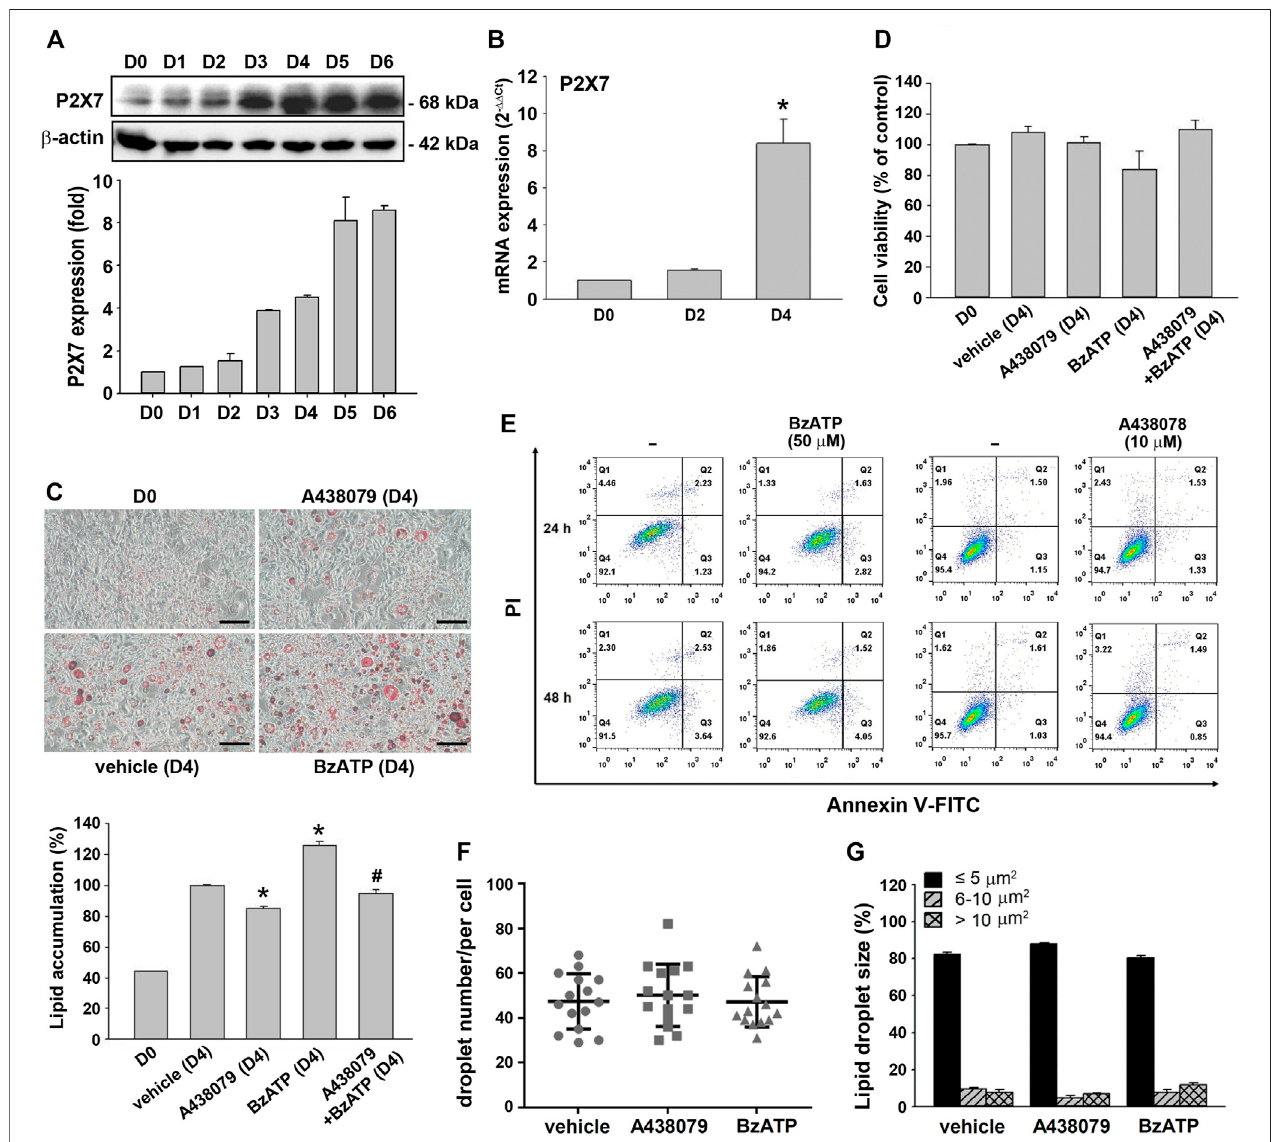
FIGURE 1 | P2X7 expression and lipid accumulation during adipocyte differentiation. (A) The protein levels of P2X7 during adipocyte differentiation (D0-D6) were measuredbywesternblotanalysiswithquanti fi cationto β -actin. (B) ThemRNAlevelsof P2X7 duringadipocytedifferentiation(D0,D2,andD4)weremeasuredbyqPCR. * p < 0.05 vs .preadipocytes(D0). (C) Cellswere treated withA438079 (10 μ M) orBzATP (50 μ M) at D0 and again at the end ofD2upon the renewalofthe differentiation media.Aftertwo-stageadipocytedifferentiation,theintracellularlipidwasstainedbyOilRedO.Scalebar:100 μ m.TheOilRedOstainwasextractedinisopropanol and was used to measure the value at 510 nm * p < 0.05 vs . vehicle-treated adipocytes (D4) and # p < 0.05 vs . adipocytes treated with BzATP (D4). (D) Cell viability of adipocytes atD4 wasmeasured byTrypanBlue cellcounting. (E) 3T3-L1preadipocyteswere treatedwith A438079 orBzATP for24-48 h. Cell viabilitywasdetermined by fl ow cytometry. The (F) droplet numbers and (G) droplet sizes in vehicle-, A438079-, and BzATP-treated cells were measured at D4 using SGcapture software (Optical Gaging Products). All quantitative data are presented as mean ± SEM from at least three independent experiments.